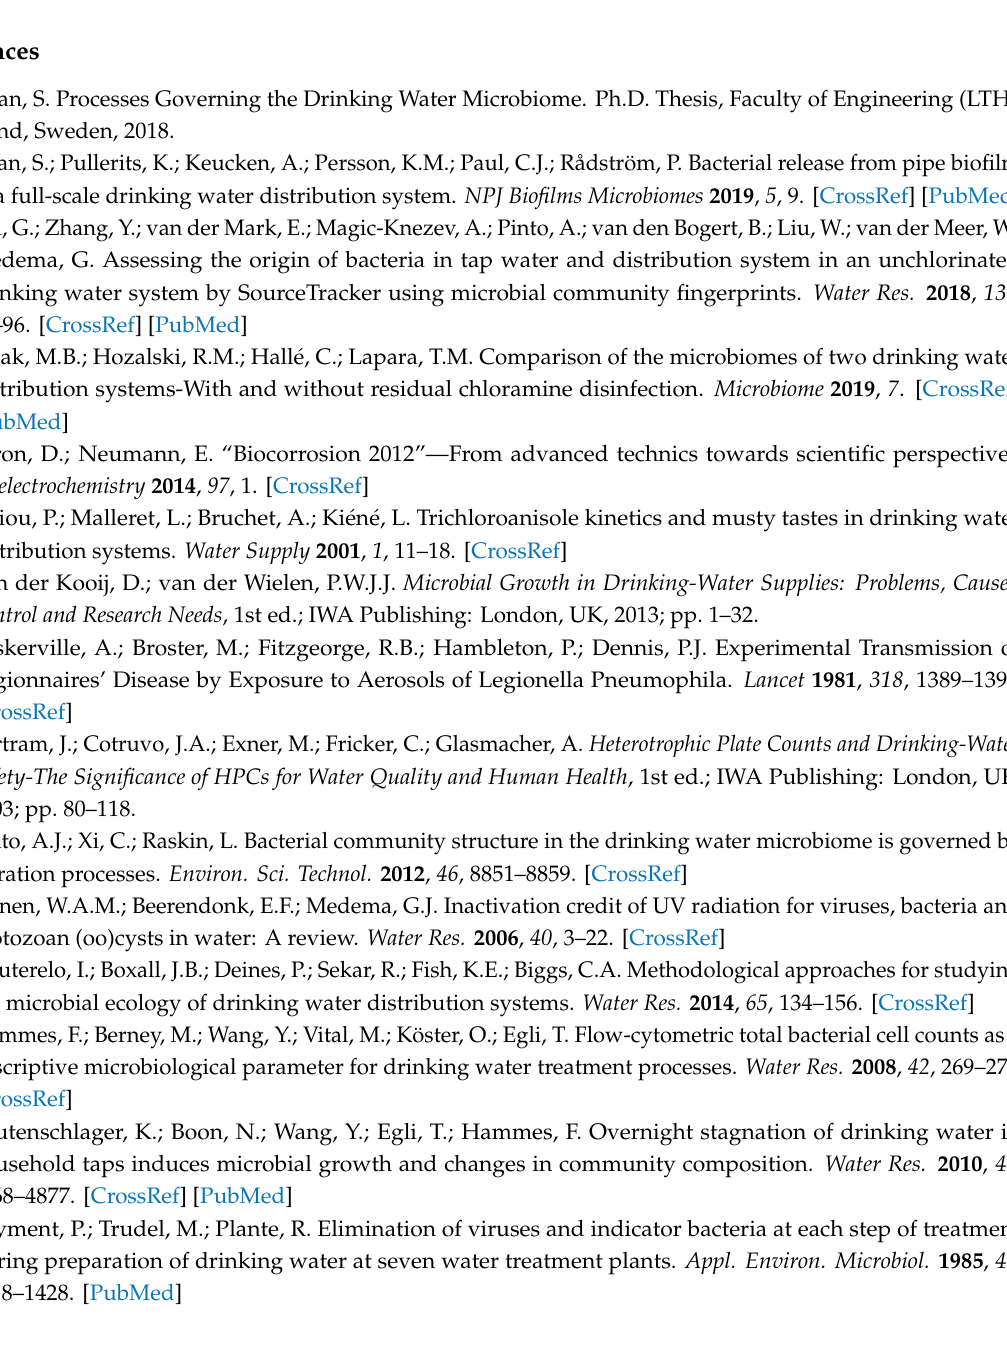
Hunst; Figure S6: Changes in TCC, ICC, and water temperature at sampling point TrPS5; Figure S7: Increase in TCC at sampling point TrPS5 in late June 2019; Figure S8: TOCeq measured in the permeate of the UF membrane from April 2018 to April 2019; Table S1:Flow cytometry results and environmental parameters for di ff erent sampling